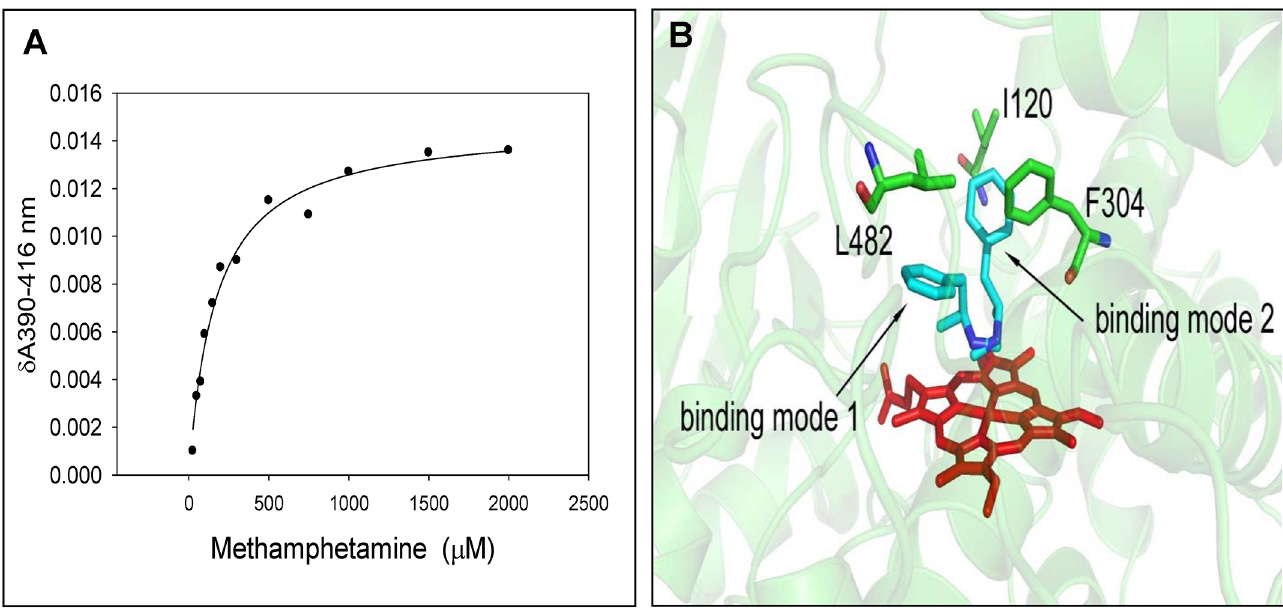
Fig 2. Spectral binding of methamphetamine with CYP3A4. (A) The spectral binding was performed at varying concentrations of methamphetamine from 1 μ M to 2 mM. The graph was plotted using difference in absorbance at 390 and 416 nm vs. concentration of methamphetamine. The graph was fitted with hyperbolic equation using non-linear regression analysis in sigma plot 11. (B) Docking simulation of methamphetamine binding with CYP3A4 in two different binding modes. The heme, methamphetamine, and interacting amino acid residues of CYP3A4 are represented in red, green, and blue,